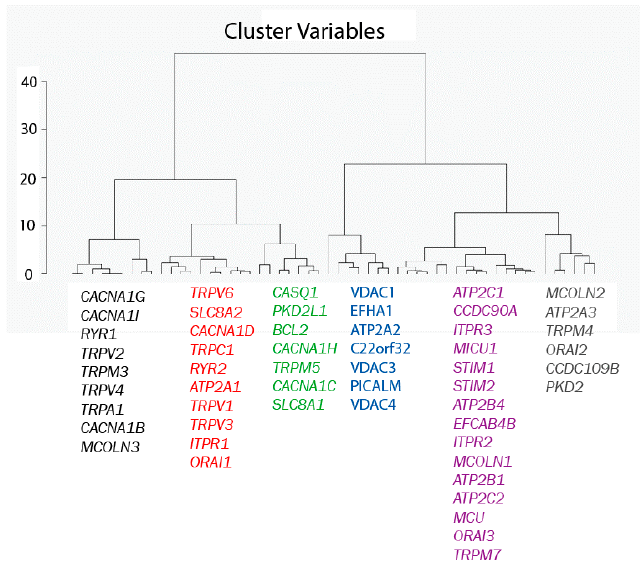
Figure 4. Hierarchical clustering of genes. Genes have been divided into six different groups according to their Euclidean distances relative to their expression values (in RPKM).